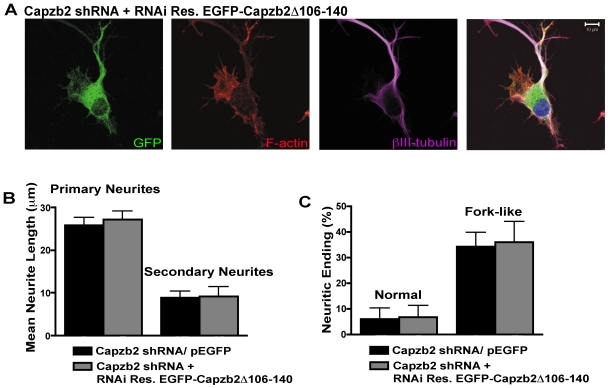
Capzb2 lacking the region that interacts with microtubules fails to rescue the Capzb2 RNAi phenotype.(A) Neurons were analyzed following PHEM fixation 48 h posttransfection with either Capzb2shRNA/pEGFP or Capzb2 shRNA+EGFP-Capzb2Δ106–140; a representative neuron in shown: GFP channel indicates GFP-Capzb2Δ106–140 distribution similar to the distribution of GFP-Capzb2 signal shown in Figure 2G; however, no growth cones are seen ([A] green: GFP, red: F-actin, purple: βIII-tubulin, and blue: nucleus); scale bar indicates 10 µm. (B) No significant differences (p>0.05) in the lengths of primary and secondary neurites were observed between neurons transfected with Capzb2 shRNA/pEGFP and neurons transfected with Capzb2 shRNA+EGFP-Capzb2Δ106–140; mean values ±s.e.m. are depicted (n = 25). (C) No significant differences (p>0.05) in percentages of normal and fork-like growth cones/neuritic endings were observed between neurons transfected with Capzb2 shRNA/pEGFP (25 neurons = 67 growth cones/actin-rich neuritic endings) and neurons transfected with Capzb2 shRNA+EGFP-Capzb2Δ106–140 (25 neurons = 50 growth cones/actin-rich neuritic endings); mean values ±s.e.m. are depicted.